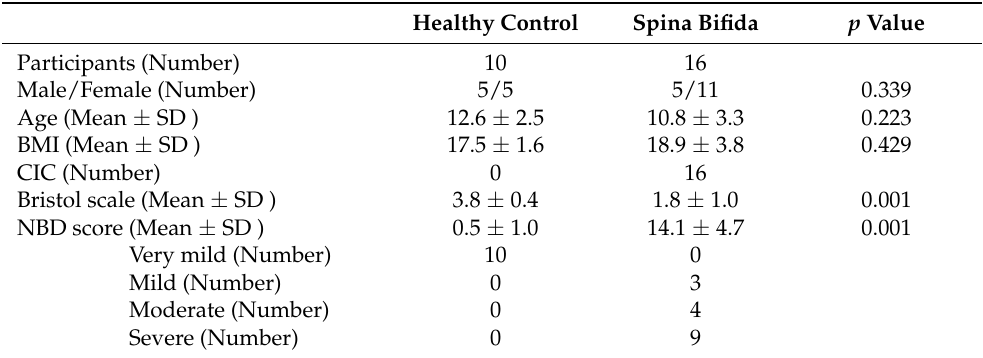
Table 1. Characteristics of the study groups. BMI: body mass index; CIC: clean intermittent catheteri- zation; NBD: neurogenic bowel